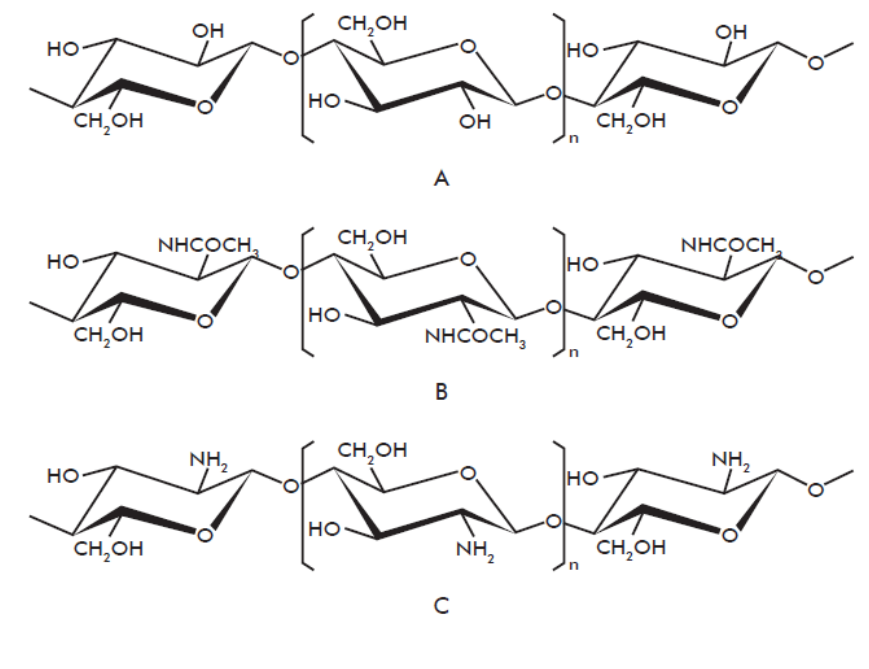
Figure 1. The structural representation of the repeating polymer chains of ( A ) cellulose, ( B ) fully acetylated chitin and ( C ) fully deacetylated chitosan, evidencing their structural similarity. In addition to being deacetylated, chitosan applied in agriculture is also commonly shorter chained. Taken from Ramírez et al.